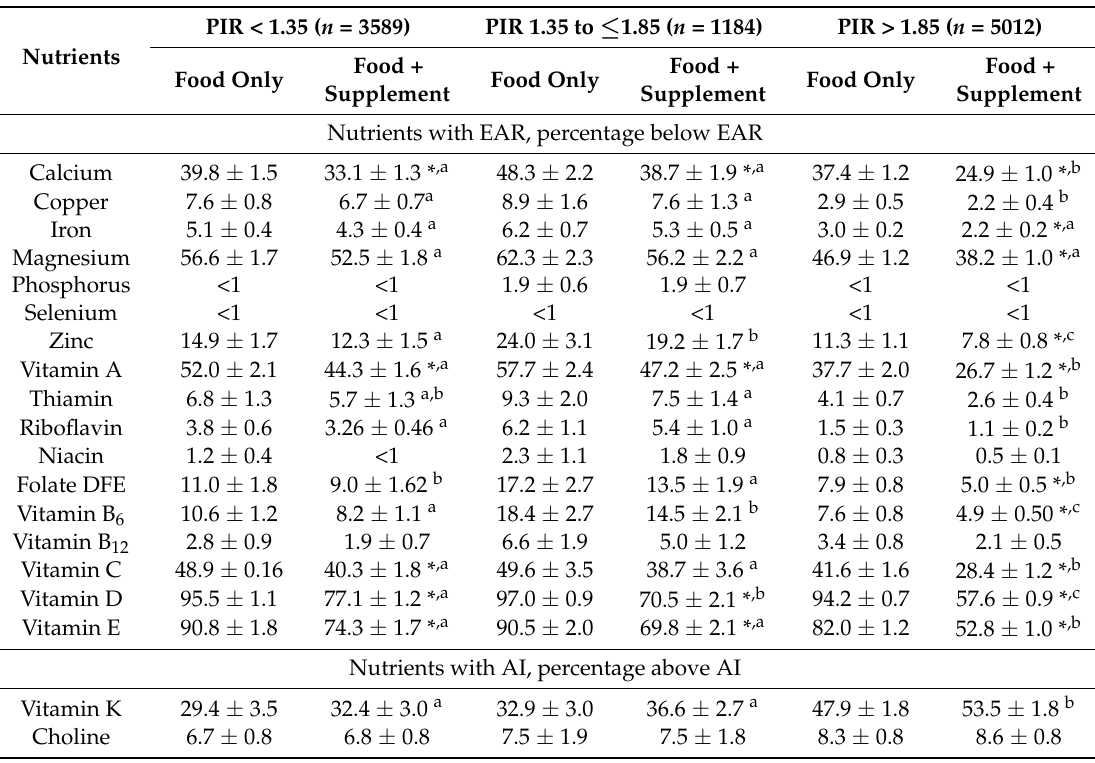
Table 4. Percent of adult (19+ years old) population below Estimated Average Requirement (EAR) or above Adequate Intake (AI) of nutrients from foods and foods + dietary supplements by Poverty-Income-Ratio (PIR). NHANES 2009–2012 gender combined